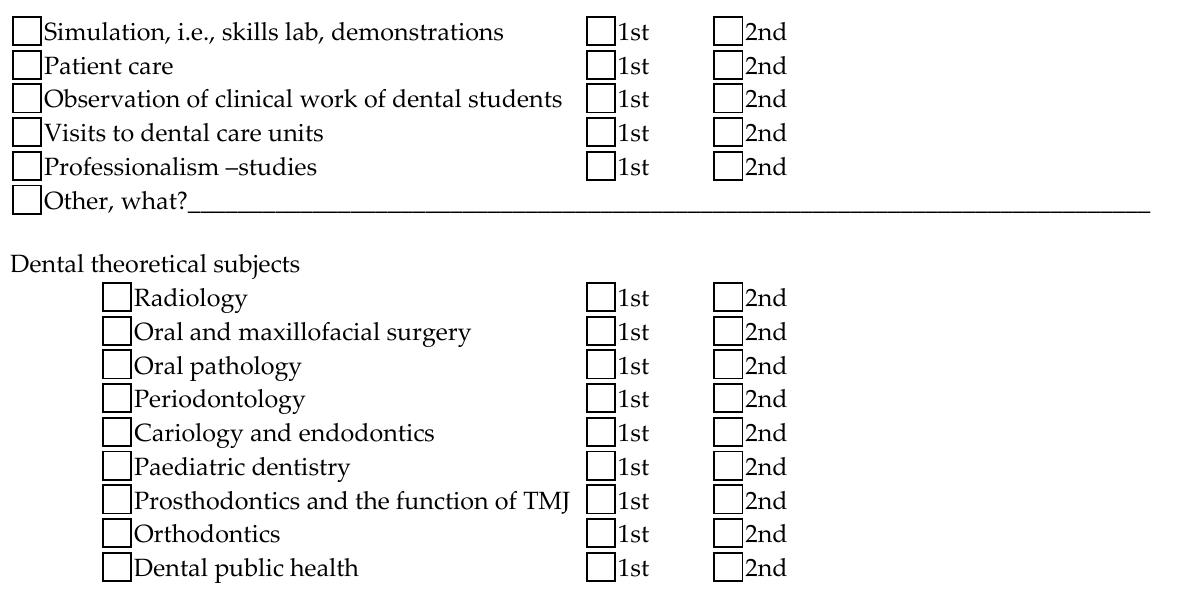
Table A4. III Learning methods. Evaluate how different learning methods support your learning. Circle the option “Not applicable” if you have not participated in the learning method.